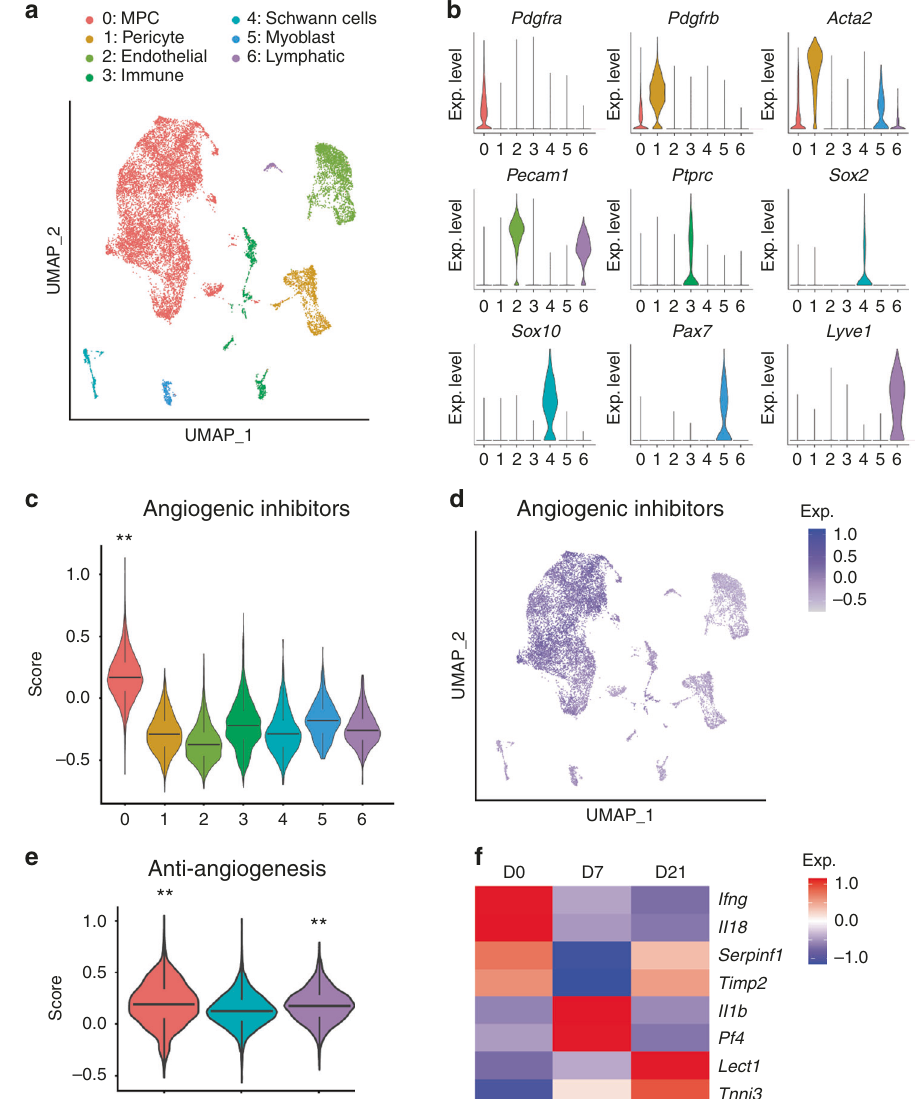
Fig. 6 HO induction prohibits anti-angiogenesis phenotype. Single cell RNA sequencing analysis of pooled cells from the injury site, obtained at 0, 7 and 21 days post-injury. a UMAP visualization of seven cell clusters including mesenchymal progenitor cells (MPCs), pericytes, endothelial cells, pericytes, immune cells, Schwann cells, myoblast and lymphatic cells. b Violin plots demonstrating characteristic markers of each cell cluster. Pdgfra (Platelet-derived growth factor receptor alpha), Pdgfrb (Platelet-derived growth factor receptor beta), Acta2 (Actin alpha 2), Pecam1 (Platelet endothelial cell adhesion molecule 1), Ptprc (Protein tyrosine phosphatase receptor type c), Sox2 (SRY-box transcription factor 2), Sox10 (SRY-box transcription factor 10), Pax7 (Paired box 7), Lyve1 (Lymphatic vessel endothelial hyaluronan receptor 1). c Module score analysis of angiogenic inhibition across seven cell clusters. Gene lists for modular scores are shown in File S1. d UMAP visualization of expression of anti-angiogenic factors across 7 cell clusters. e Module score analysis of angiogenic inhibition across time. f Heatmap of 8 anti-angiogenic genes across time, including Ifng (Interferon gamma), Il18 (Interleukin 18), Serpinf1 (Serpin family F member 1), Timp2 (Timp metallopeptidase inhibitor 2), Il1b (Interleukin 1 beta), Pf4 (Platelet factor 4), Lect1 (Chondromodulin), and Tnni3 (Troponin I3). ** P < 0.01, non-parametric data was analyzed using the Kruskal – wallis with Dunn ’ s multiple comparison test ( c , e